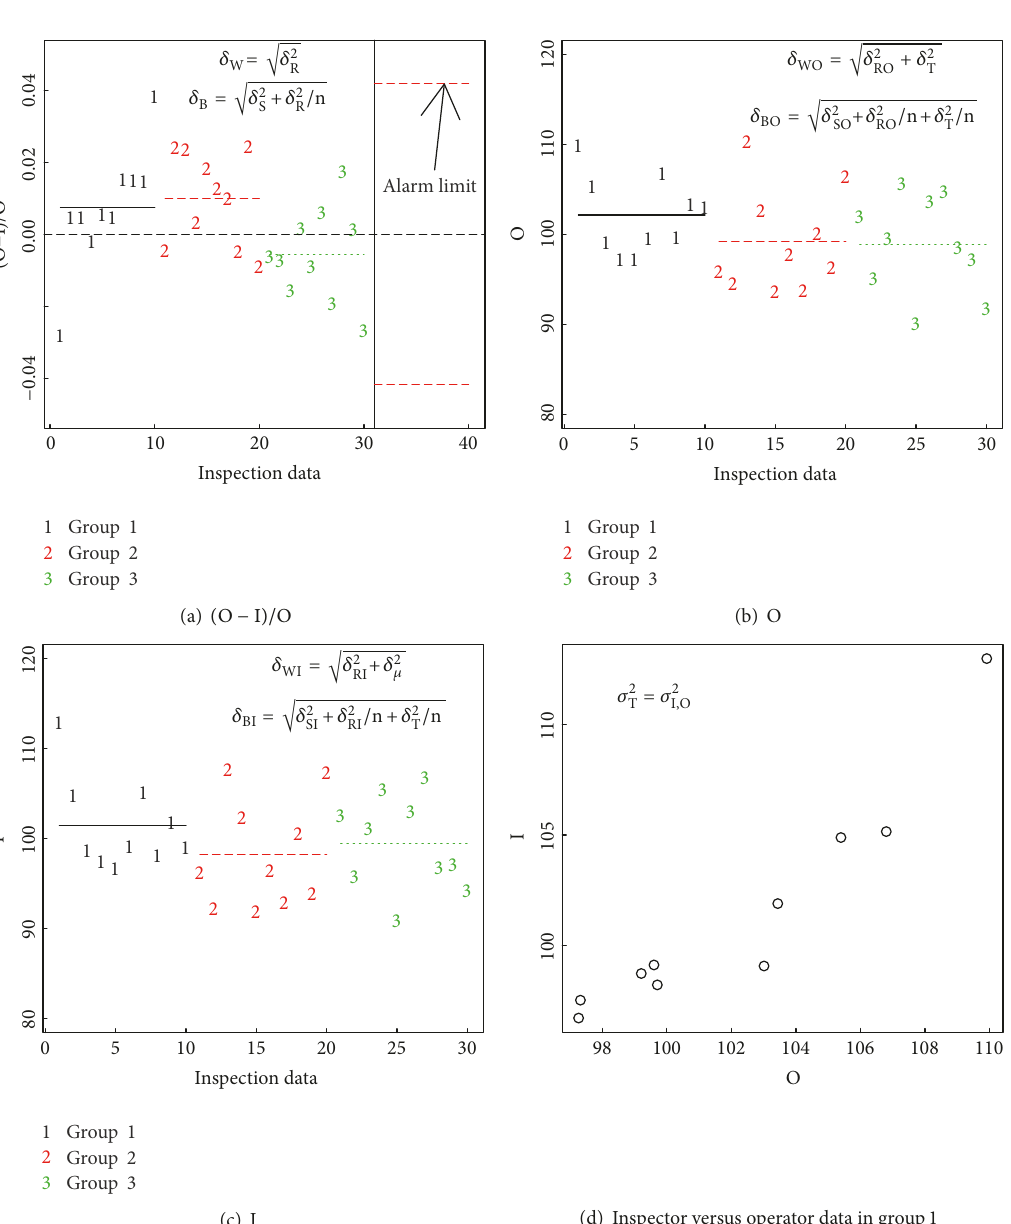
Figure 1: Example (simulated) of 10 𝑑 = (𝑂−𝐼)/𝑂 values in each of 3 groups. 𝛿 𝑅𝑂 = 0.005,𝛿 𝑆𝑂 = 0.001, 𝛿 𝑅𝐼 = 0.02, 𝛿 𝑆𝐼 = 0.01, 𝛿 𝑇 = 0.05,𝜇 𝑇 = 100